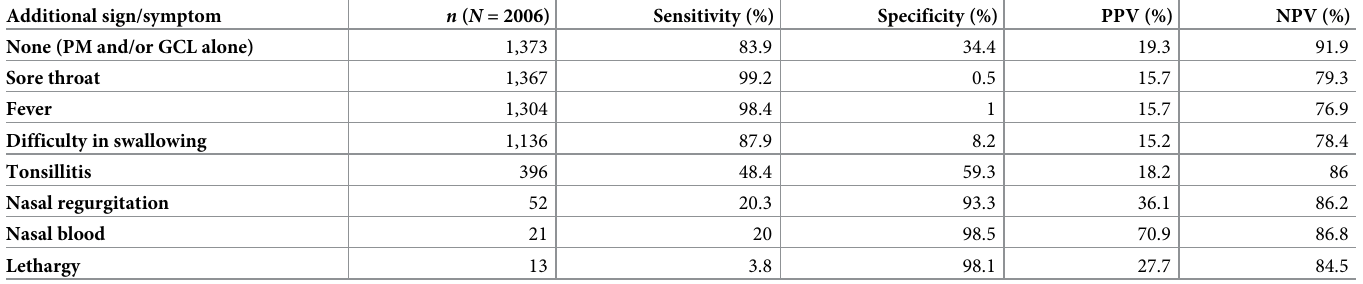
Table 5. Sensitivity, specificity, PPV, and NPV of an enhanced probable case definition (presence of either PM and/or GCL) with inclusion of additional signs and symptoms, Cox’s Bazar, Bangladesh, November 10, 2017 to November 10, 2019.